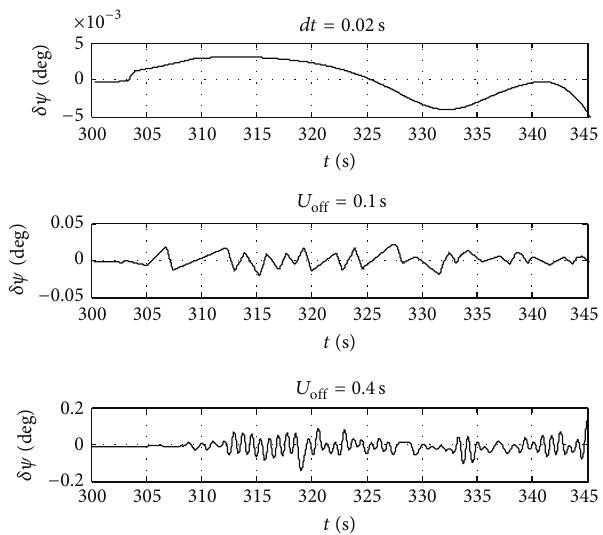
Figure 33: Simulation result of yaw angle deviation.